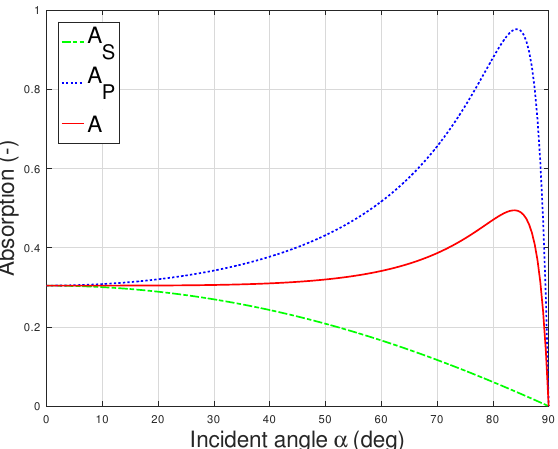
Figure 7. Absorption of laser power by 304L stainless steel at melting point ( n = 9.09, κ = 4.21 [28]) as a function of incident angle according to Equations